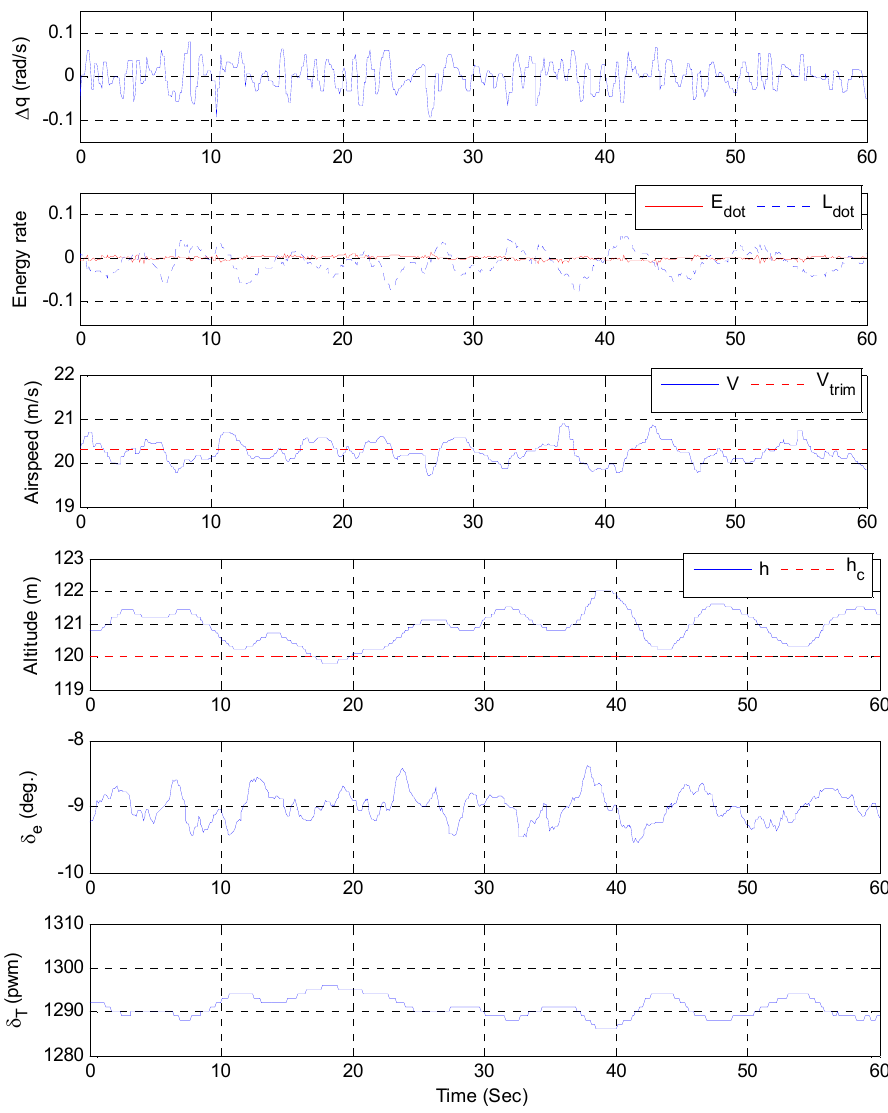
Figure 14. Simulation results of level flight with the presence of wind.